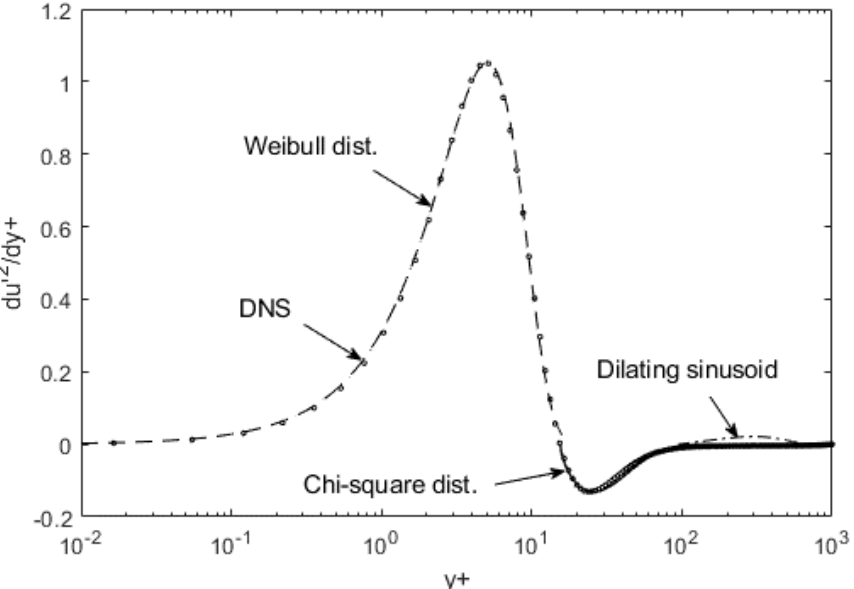
Figure A2. Weibull and chi-square distribution functions for du’ 2 /dy+. A hypothetical sinusoid is added, which produces the secondary peak in the u’ 2 profile shown next.